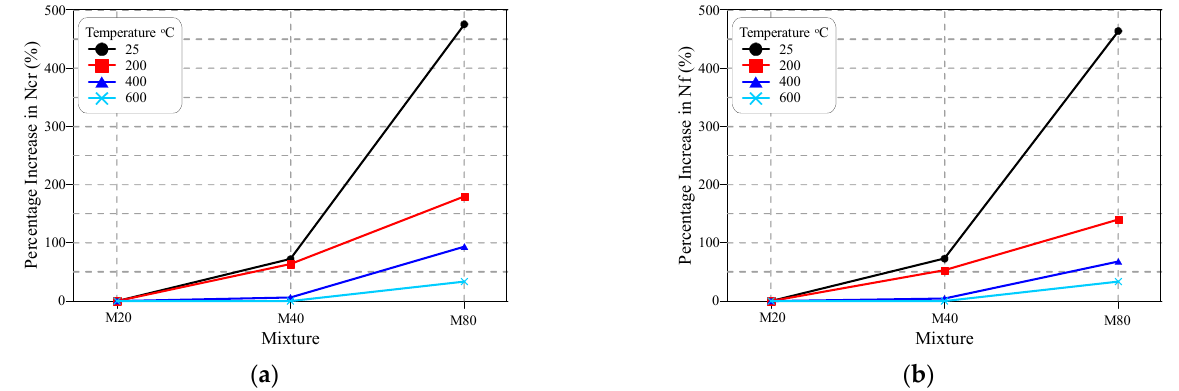
Figure 10. Percentage increase in impact numbers of M40 and M80 compared to M20: ( a ) Ncr, ( b )